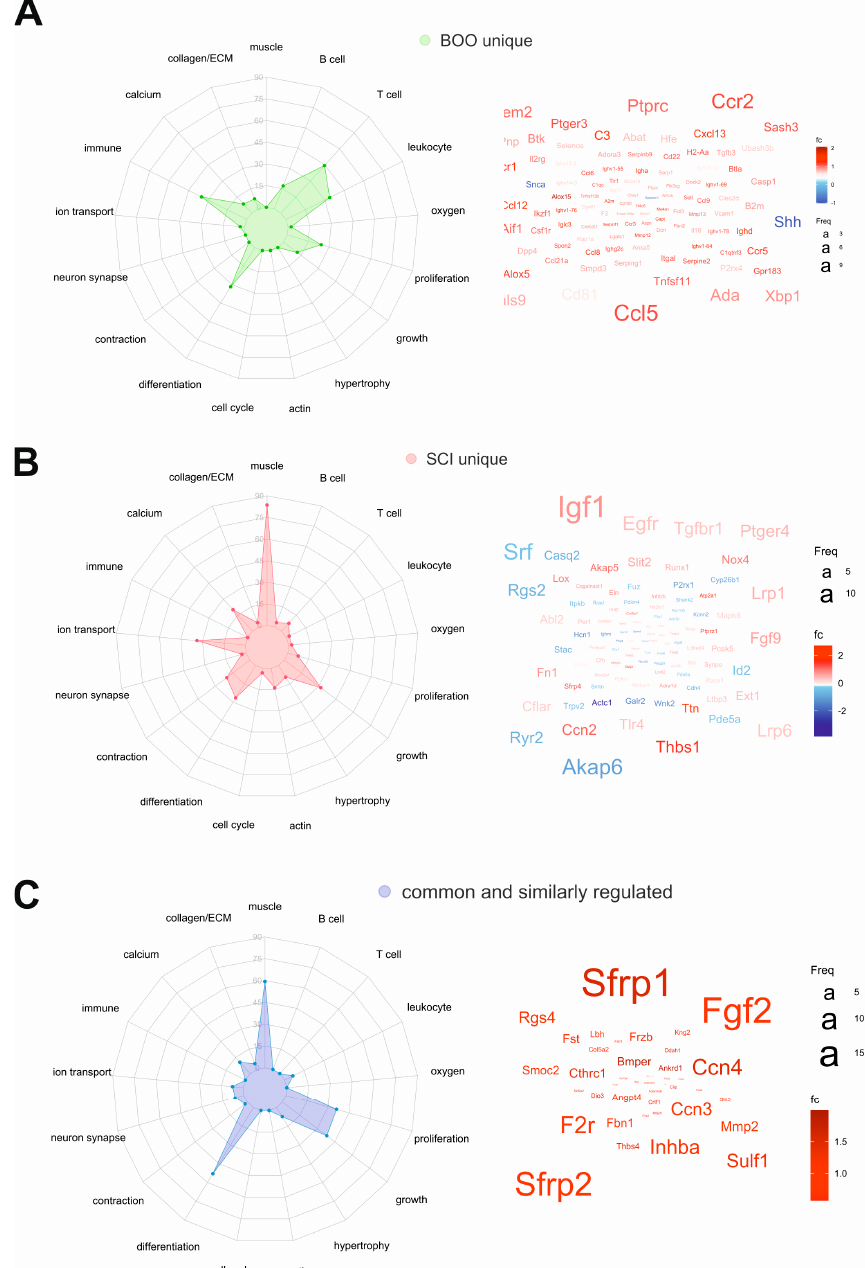
Figure 7. Unique and common biological processes in pBOO and SCI bladders. Radar graphs for major BPs and word clouds for DEGs involved in the majority of BPs are shown. Analysis was per ‐ formed using ( A ) DEGs only regulated in pBOO bladders (pBOO unique), ( B ) DEGs only regulated in SCI bladders (SCI unique), and ( C ) 46 DEGs, common and similarly regulated in pBOO and SCI transcriptomes.